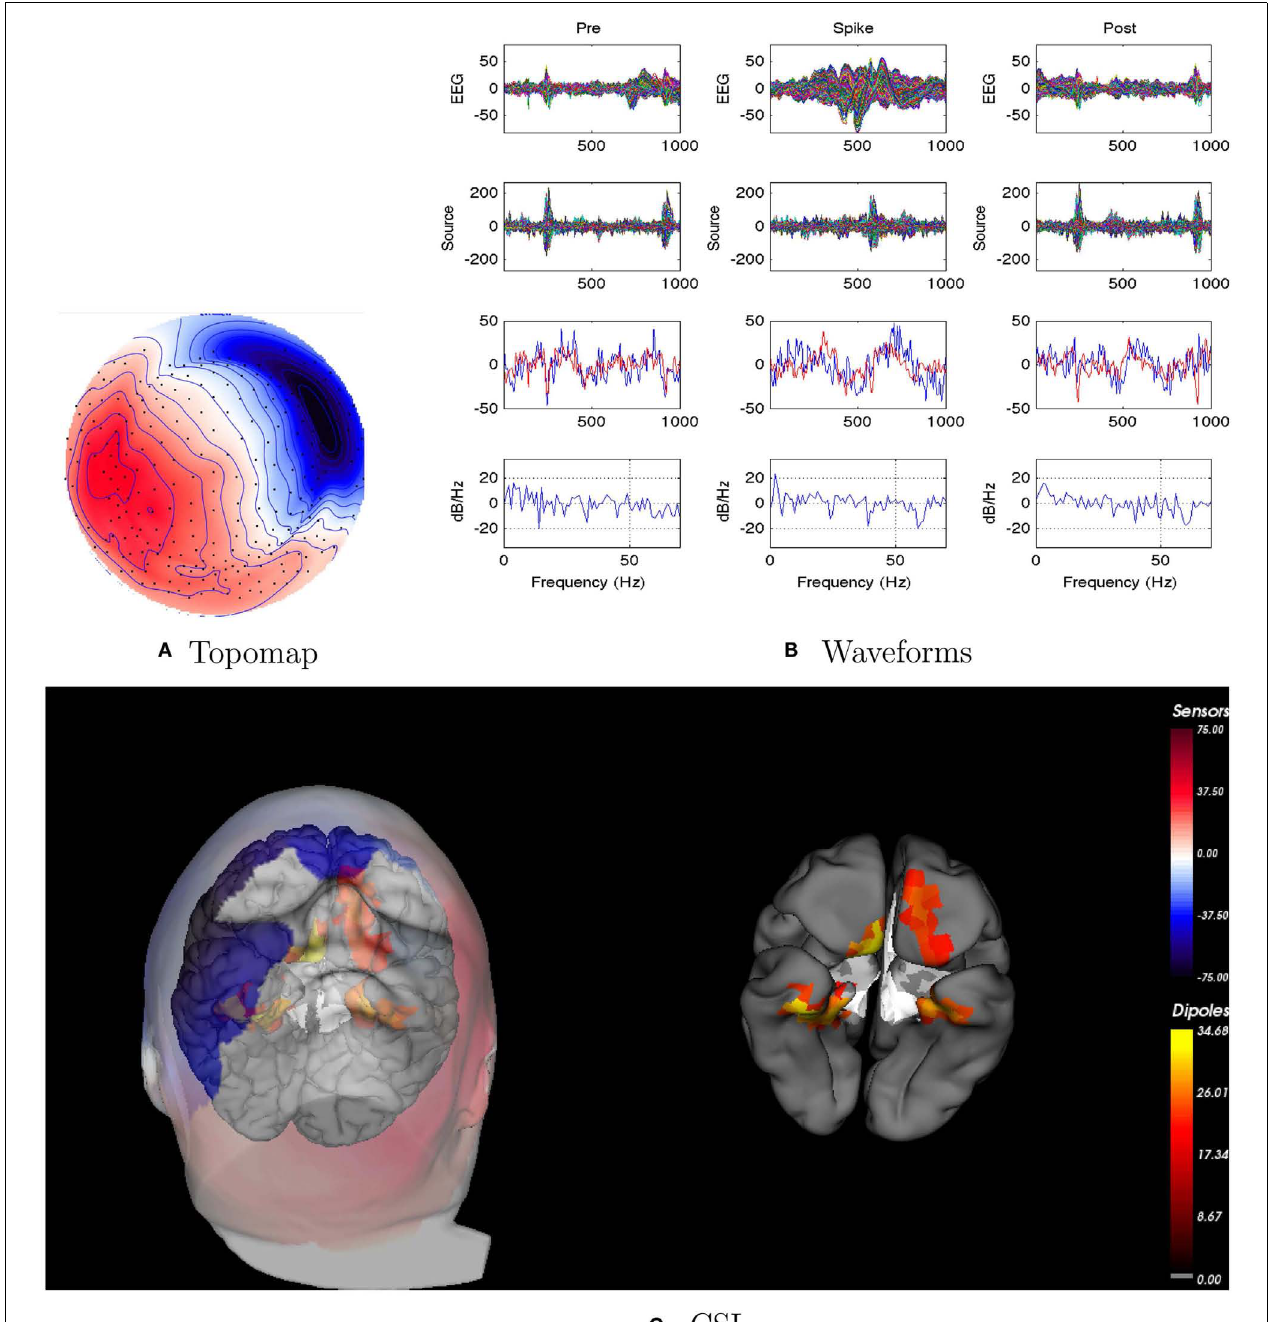
frequency spectra of the blue source waveforms (third row) shown in forth row. In (B) , each column represents 1s of data from a 3-s segment. Middle column represent data centered on the spike peak. (C) Electrical source localization with the patient’s individual electrical head model. Left: scalp potential reconstructed from the source estimate (at 50% of spike peak). Right: partially inflated brain illustrating the dominant source associated with the data illustrated in left figure (location of dipole described by blue trace in (B) , third row). Data was thresholded to only show top 5%